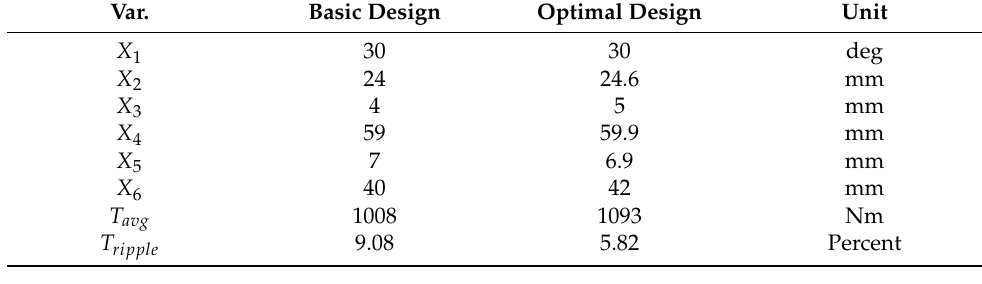
Table 4. Optimization results.